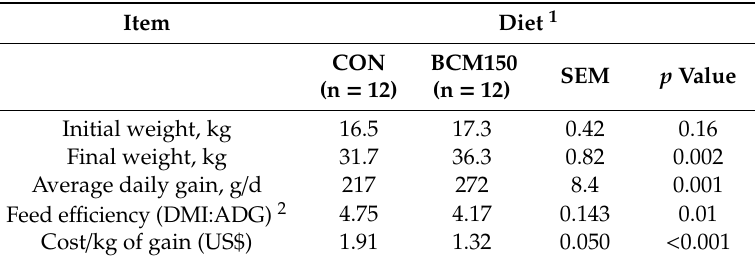
Table 4. E ff ects of feeding black cumin meal (BCM) on growth performance of Awassi lambs. Item Diet